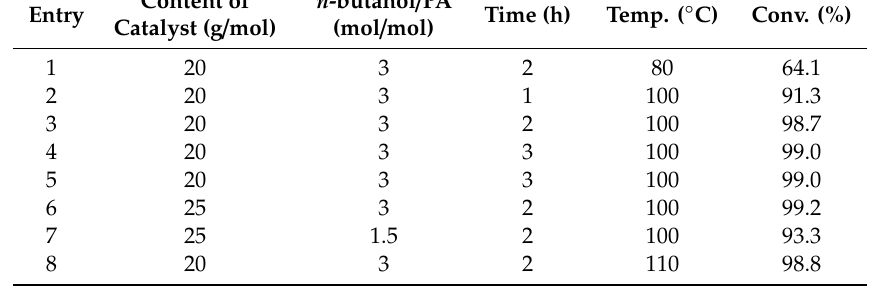
Table 3. Physicochemical properties of the used catalysts.